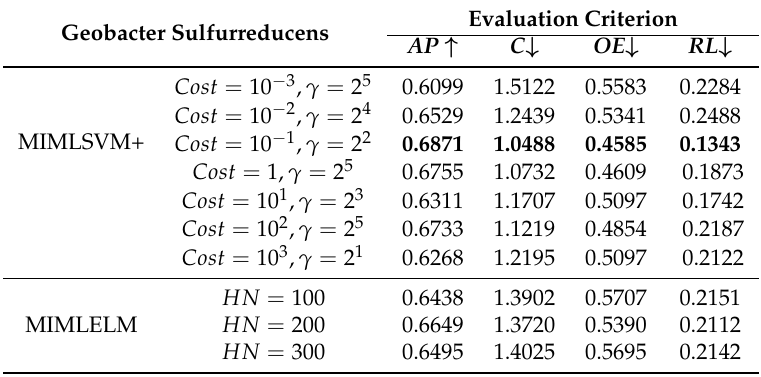
Table 4. The effectiveness comparison on the Geobacter sulfurreducens (Geob.)